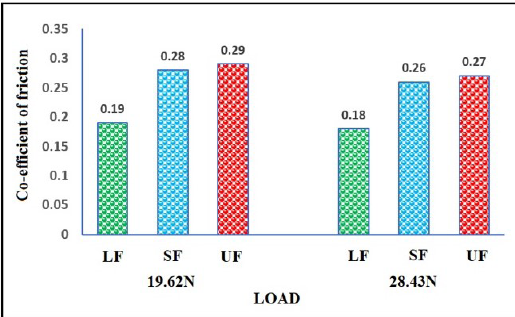
Figure 7. Hardness of the composites.